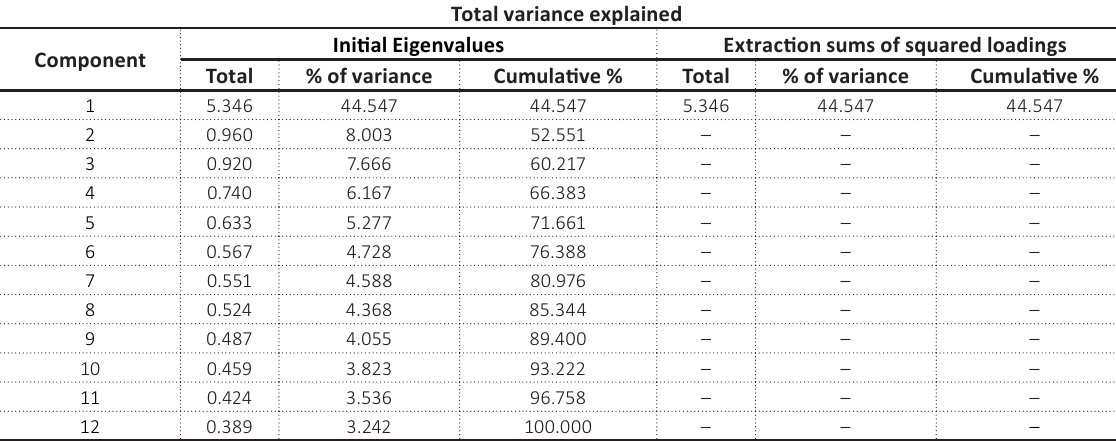
Table A3. Common method